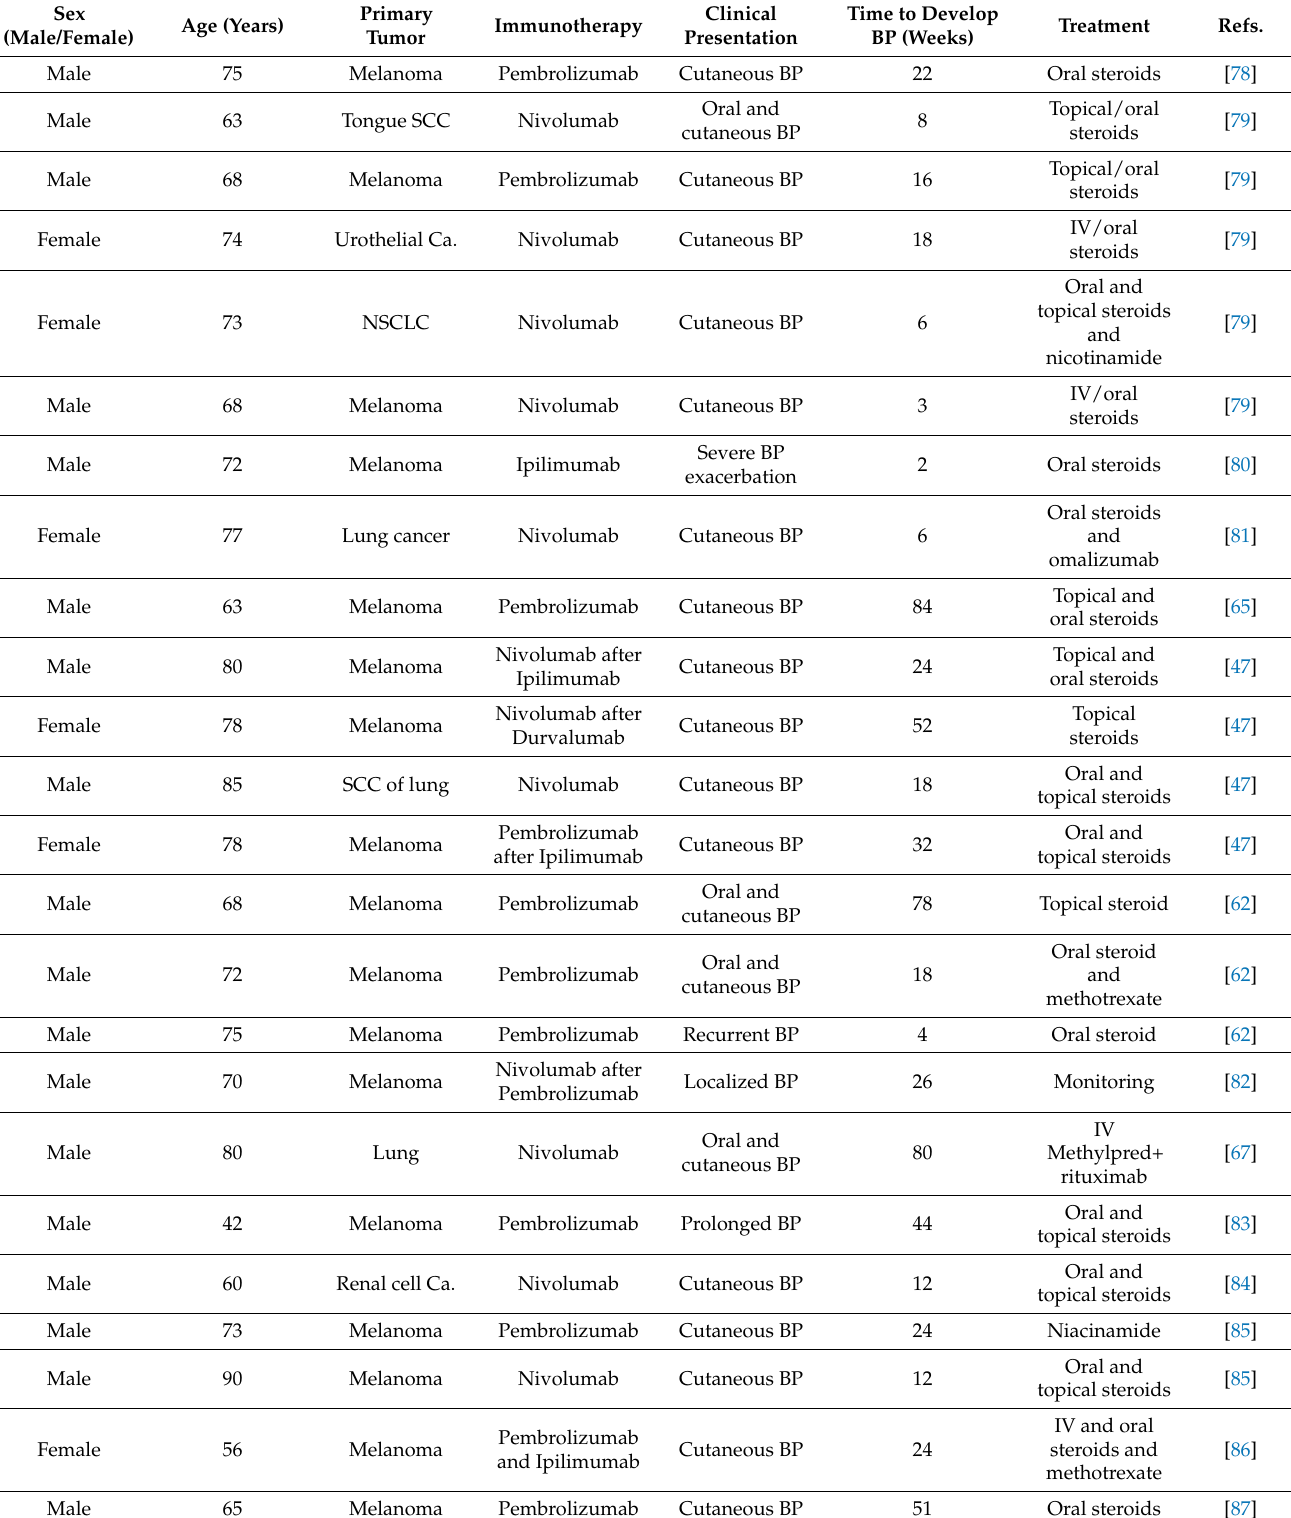
Table A1. Weeks until presentation of ICI-associated BP based on